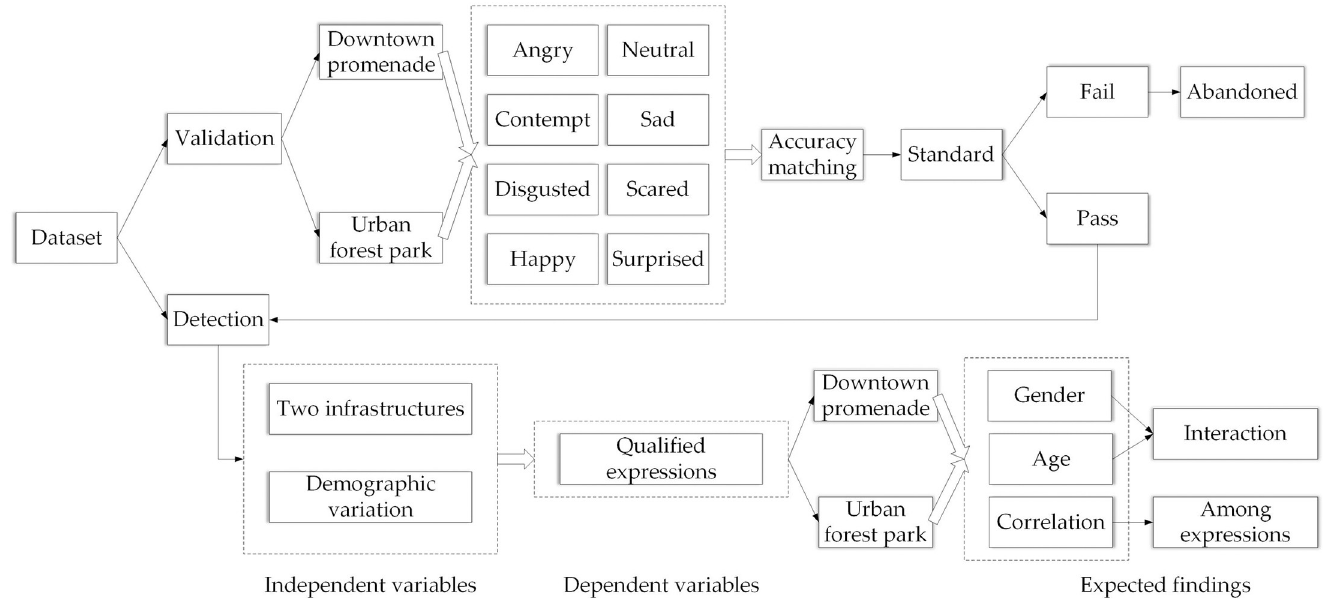
Fig 2. The whole process of the layout of whole study from validation to